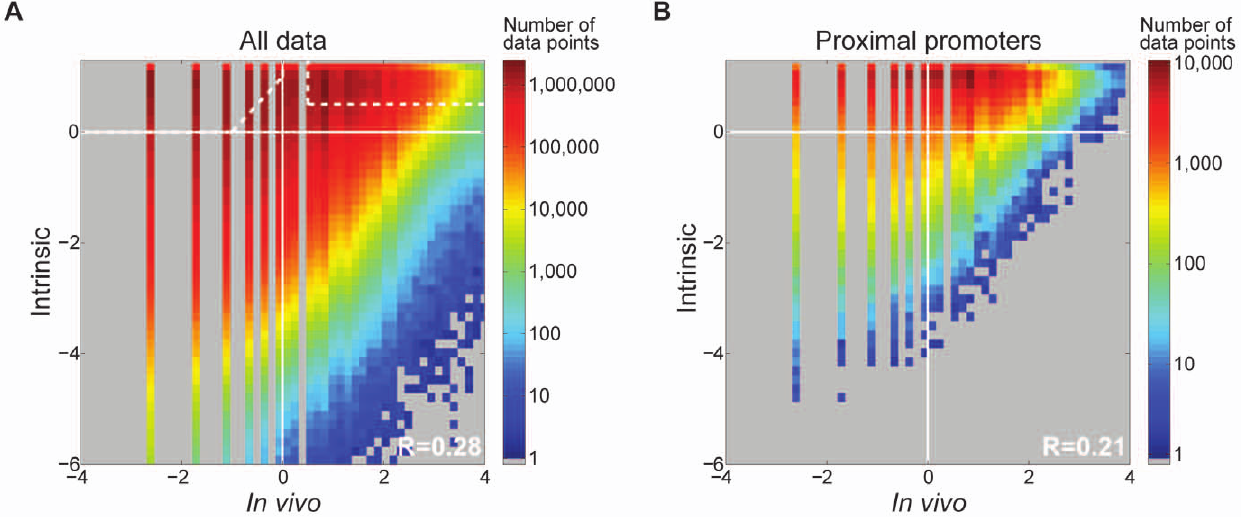
Figure 1. Intrinsic nucleosome occupancy versus invivo nucleosome occupancy in human CD4 + T-cells. Values are on a log 2 scale, comparing model score [1] vs. in vivo occupancy [8] at individual bases across ( A ) the human genome and ( B ) proximal promoters. Pearson correlation is shown. The Spearman P-value is less than 2.2 6 10 2 308 . Quantal behaviour in regions of low nucleosome occupancy is due to sequences that have a low number of reads [8]. The white dashed borders are referred to in the text. Regions of the graph with no data points are shown in gray.